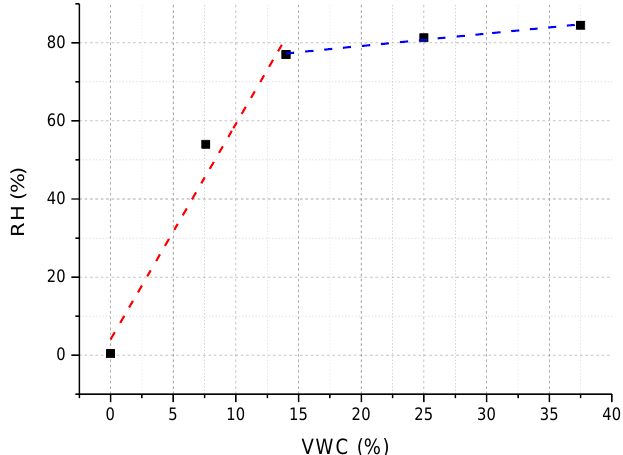
Figure 5. Optimized soil moisture sensor RH versus VWC calibration curve. Linear fitting of the data is reported with red and blue line for low and high VWC range, respectively (from Ref. [53]).